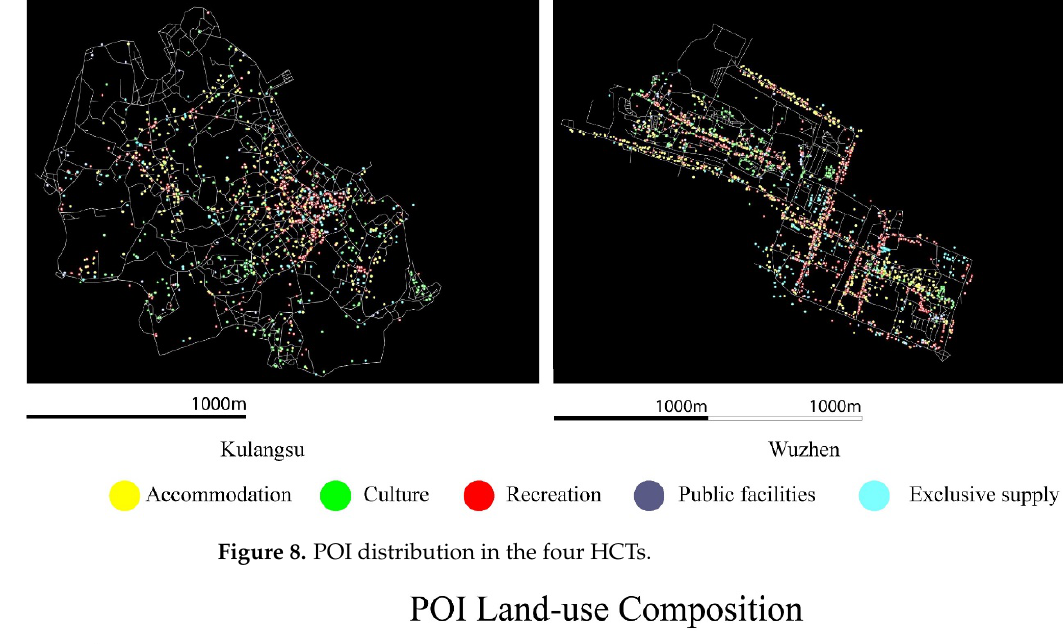
Figure 8. POI distribution in the four HCTs.